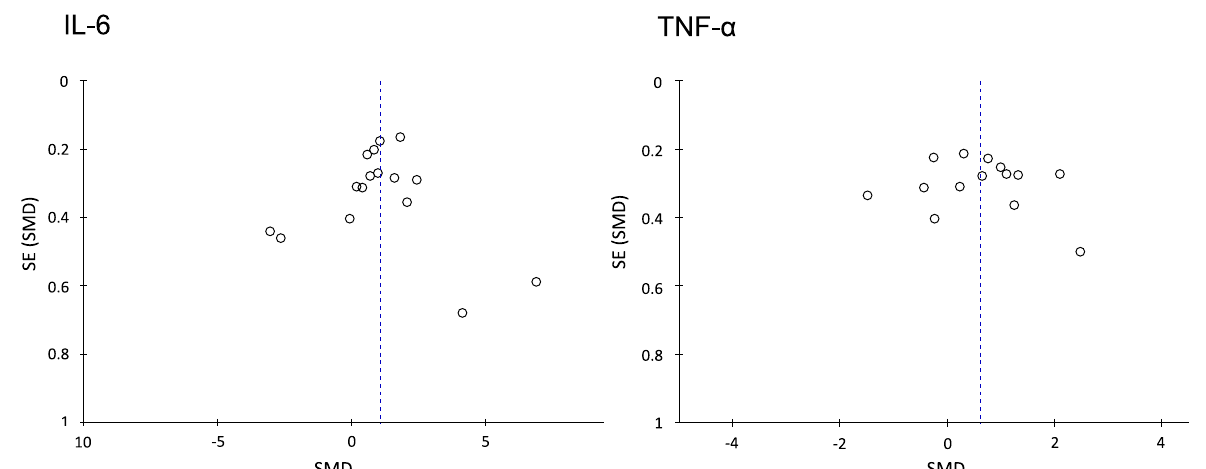
Fig. 3 Funnel plots for studies of IL-6 and TNFα in migraine compared to healthy controls. Abbreviations: IL, interleukin; TNF-α, tumour necrosis factor alpha; SD, standard deviation; SEM, standard error of the mean